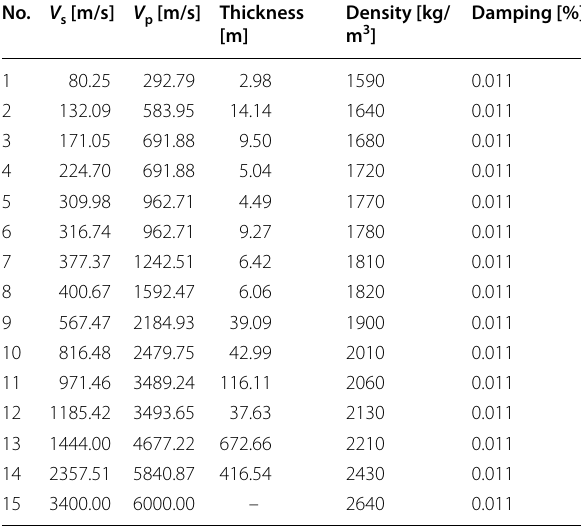
Table 1 Identified velocity structures for pEHVR at